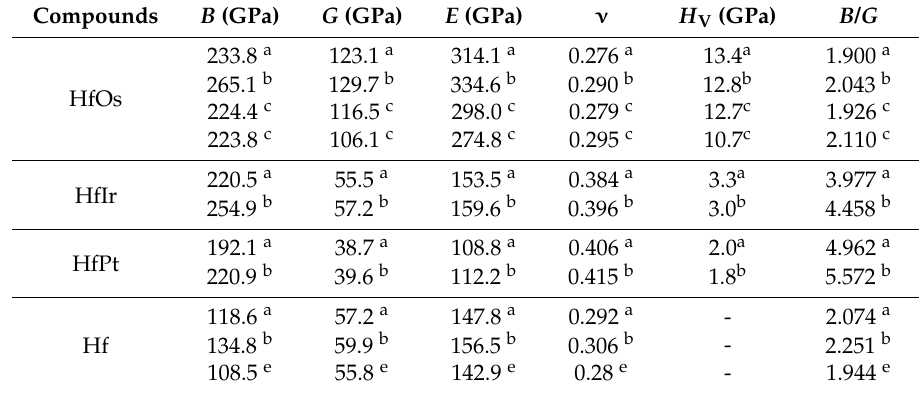
Table 3. The bulk modulus ( B ), shear modulus ( G ), Young’s modulus ( E ), Poisson’s ratio ( ν ), B / G ratio and hardness ( H V ) for HfX (X = Os, Ir and Pt) and pure Hf deduced from the VRH method. Compounds B